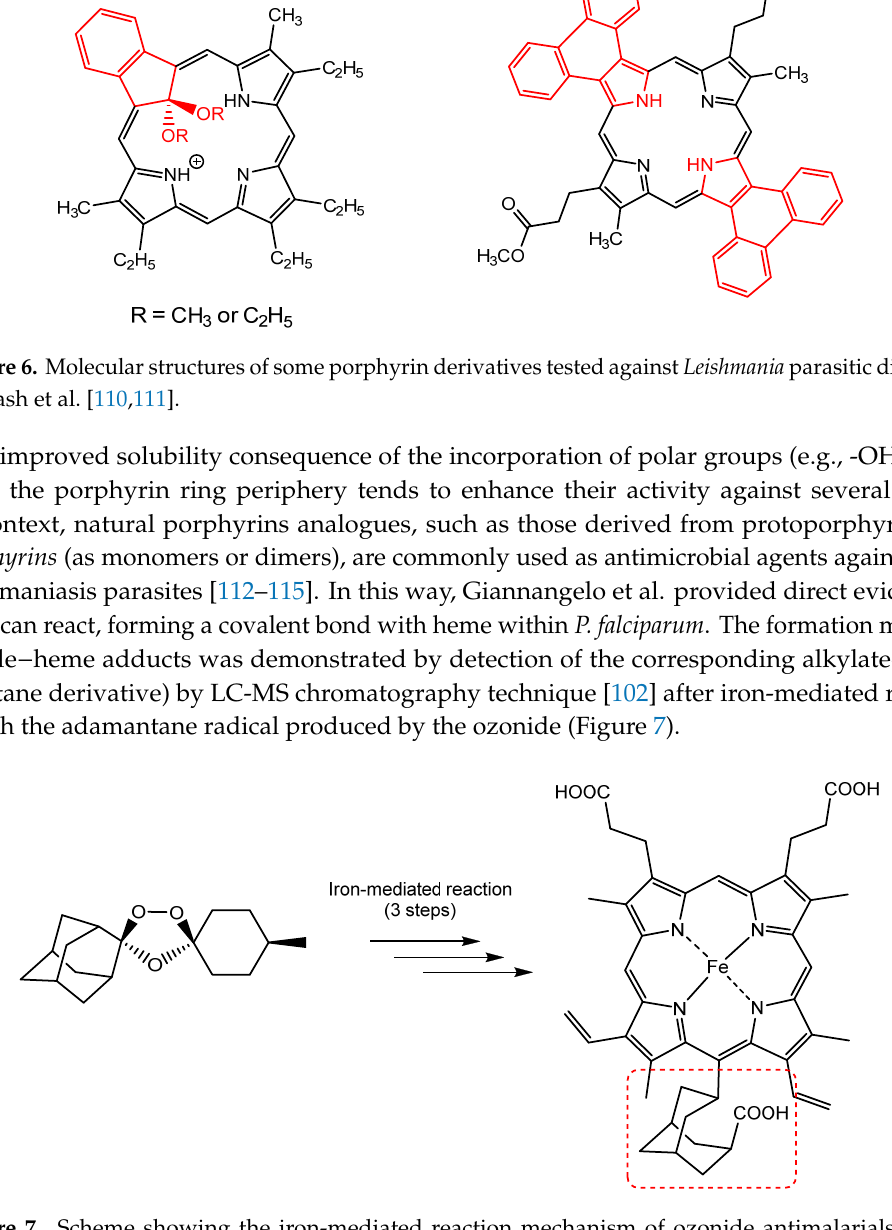
Figure 7. Scheme showing the iron-mediated reaction mechanism of ozonide antimalarials with heme forming ozonide-heme adduct, as demonstrated by the detection of the alkylated product, by Giannangelo et al. [102].